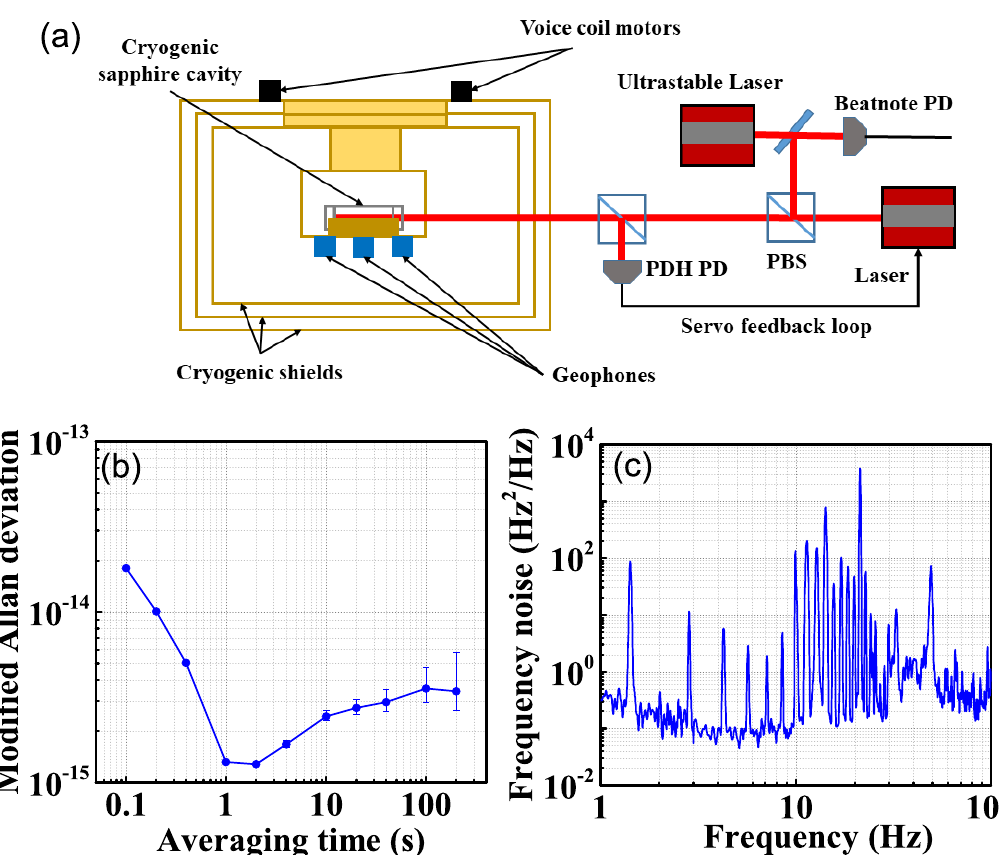
Figure 3. ( a ) Schematic diagram of the laser locking system. ( b ) Cryogenic-sapphire-cavity- based laser stability and ( c ) its frequency noise measured by beating with a room temperature cavity-based